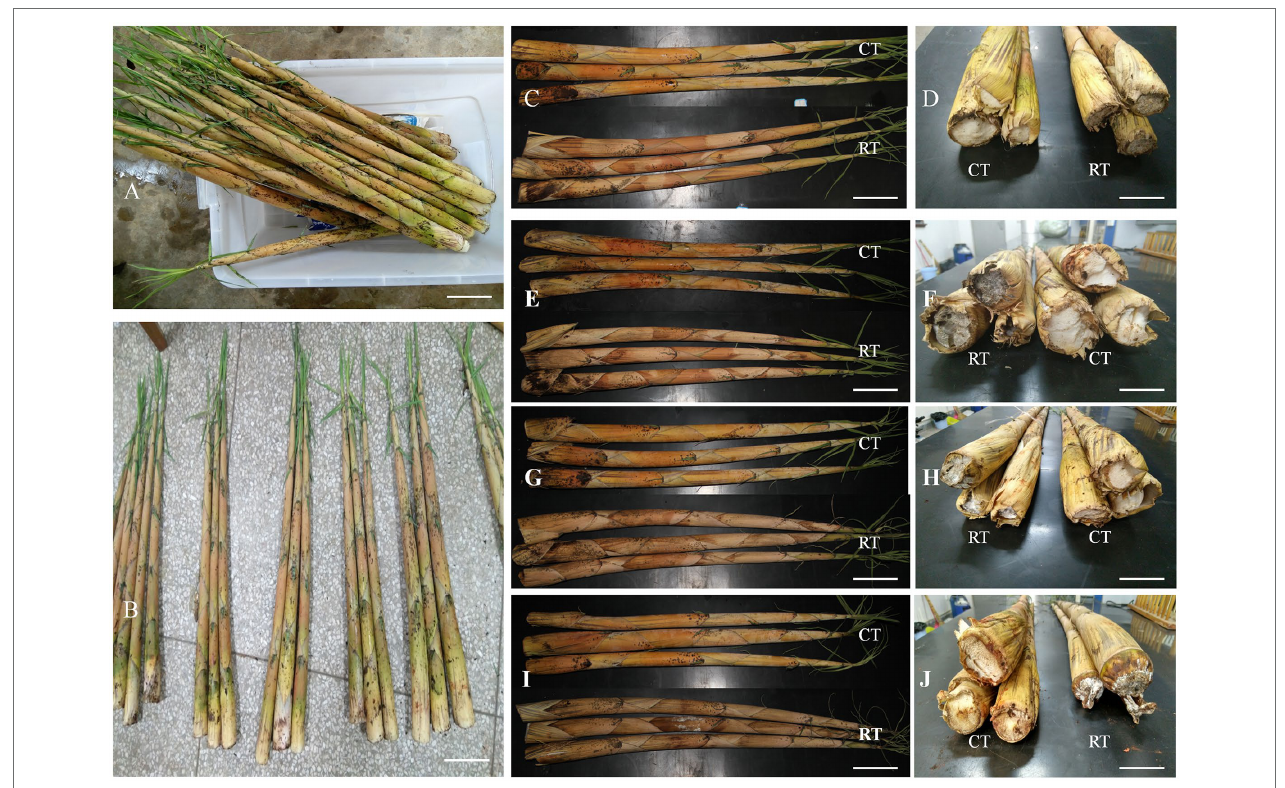
FIGURE 1 | Appearance changes in Fargesia yunnanensis shoots under different storage conditions. (A,B) Fresh-cut shoots were divided into different groups as samples. (C,D) Differences in the appearance of the shoots stored at 25 ° C and 4 ° C after 3 d. (E,F) Differences in the appearance of the shoots stored at 25 ° C and 4 ° C after 6 d. (G,H) Differences in the appearance of the shoots stored at 25 ° C and 4 ° C after 9 d. (I,J) Differences in the appearance of the shoots stored at 25 ° C and 4 ° C after 12 d. RT, bamboo shoots stored at room temperature (25 ° C); CT, bamboo shoots stored at cold temperatures (4 ° C); RT25, bamboo shoots stored at RT and analyzed at 25 ° C; and CT25, bamboo shoots stored at cold temperatures and analyzed at 25 ° C. Scale bar = 6